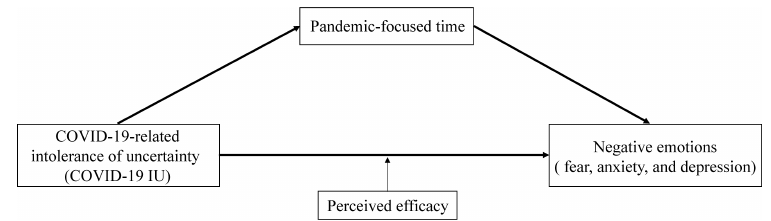
Figure 1. The hypothesized